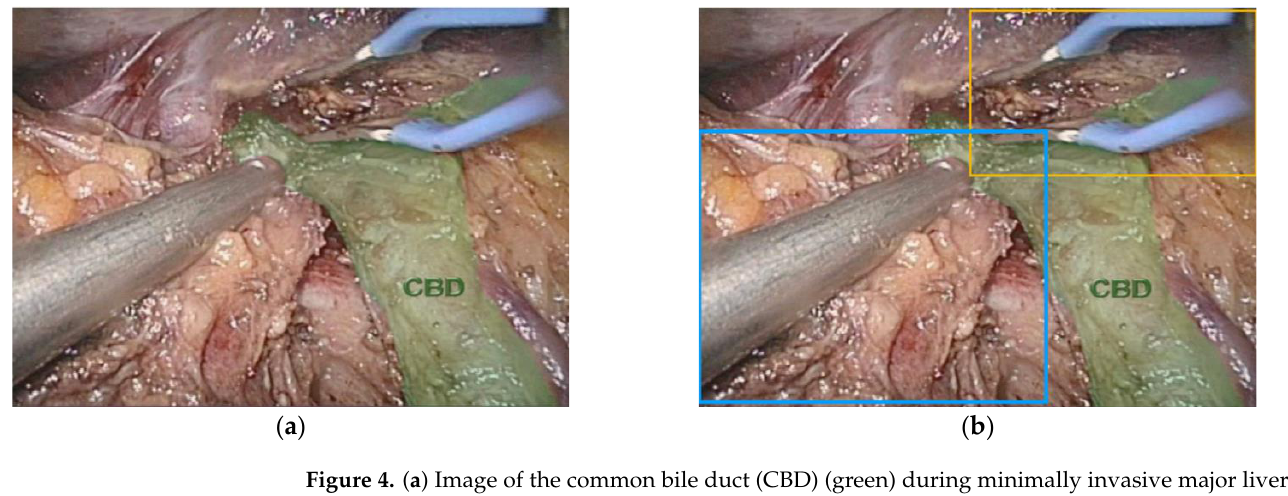
Three different colors, red, green and blue (RGB), that are visible to the human eye are used to make color images and each pixel has a specific value and a well-defined